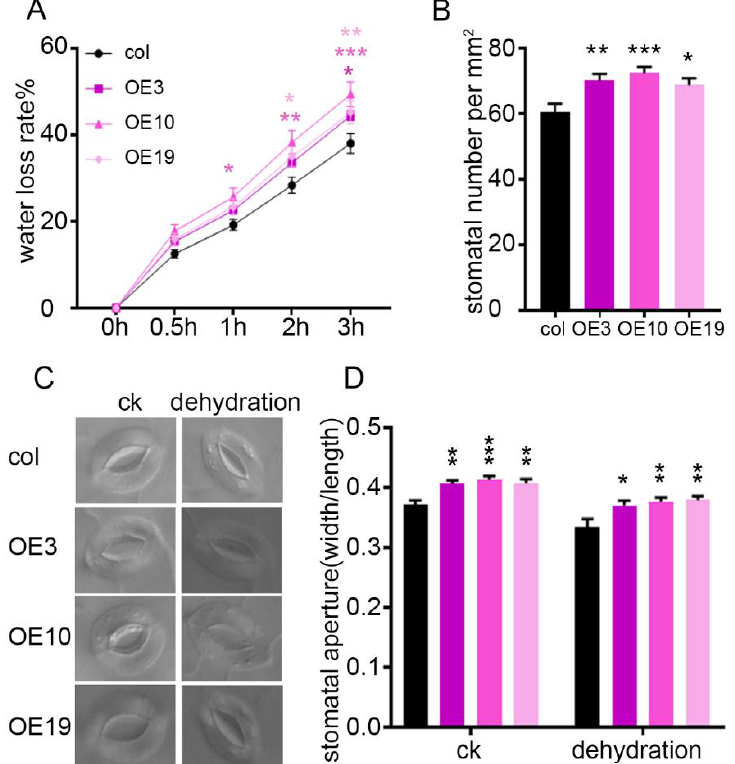
Figure 6. Water loss rate, stomatal number, and apertures of leaves in ZmLBD5 transgenic seedlings: ( A ) Water loss rate of leaves in ZmLBD5 transgenic seedlings. ( B ) Stomatal number of the fourth leaves in ZmLBD5 transgenic seedlings. Each sample had at least 12 seedlings. ( C , D ) Stomatal aperture of fourth leaves after detachment for 1 h in ZmLBD5 transgenic seedlings ( n > 30 for each sample). Significance was analyzed by one-way ANOVA. * p < 0.05; ** p < 0.01; *** p < 0.001. All bars represent means ± SD ( n ≥ 12).